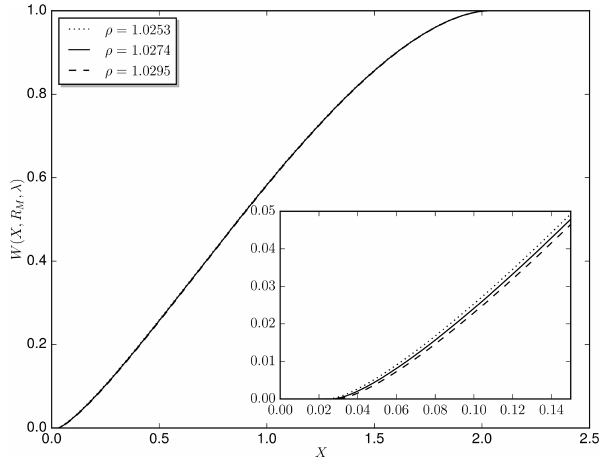
Figure 3. The relative solar irradiance w(X,R M ,λ) compared to the uncovered Sun, calculated for λ = 555nm with the limb darken- ing parametrization from Pierce and Slaughter (1977) for different ρ := R M /R S